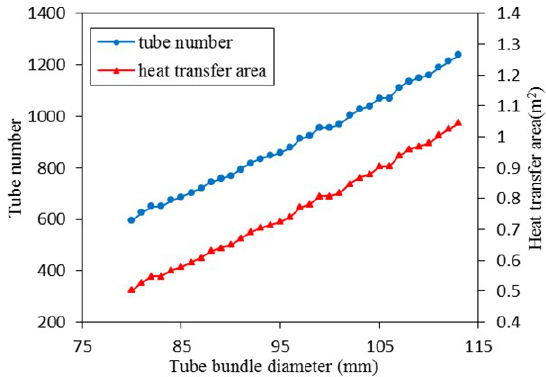
Figure 12. Tube number and heat transfer area separately versus tube bundle diameter.